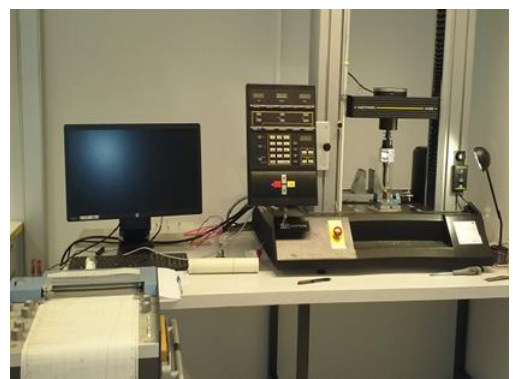
Comparison of shear bond strength (MPa) between the two groups showing mean, standard deviation, and standard error of mean.